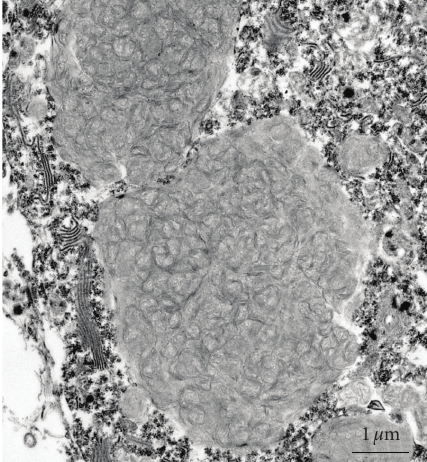
Figure 2: Electron micrograph of storage bodies from the cerebel- lum of the a ff ected Australian